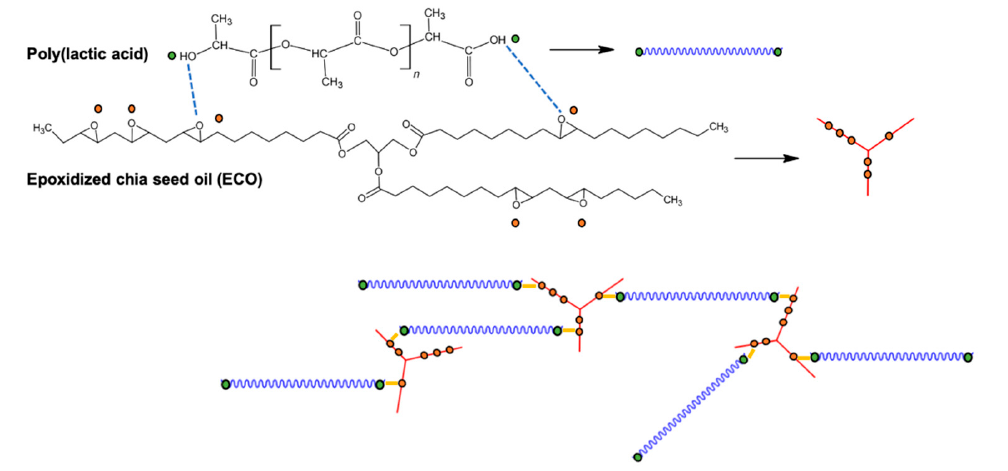
Figure 1. Schematic representation of chemical interactions between PLA and ECO.